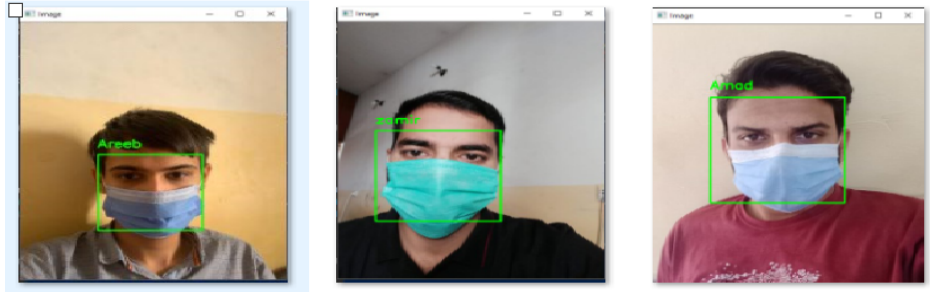
Figure 16. Output images with face